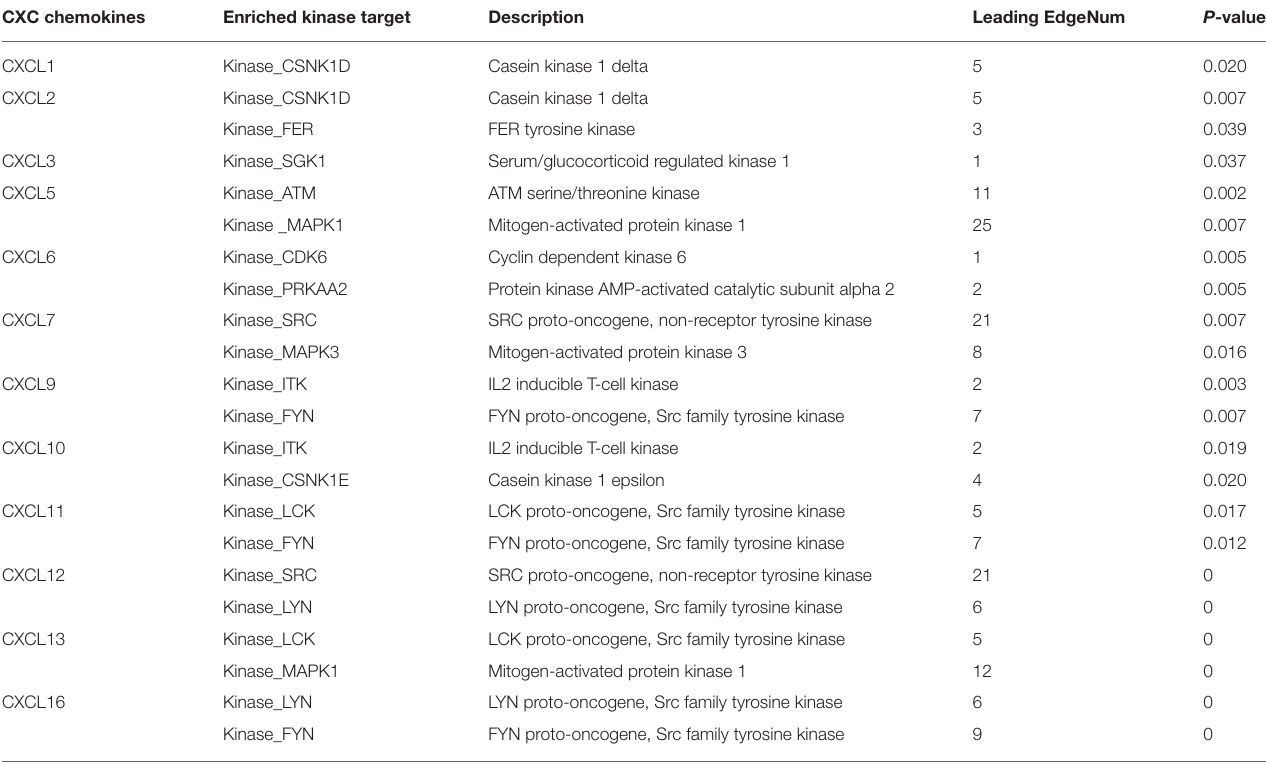
TABLE 3 | The Kinase target networks of CXC chemokines in RCC (LinkedOmics). CXC